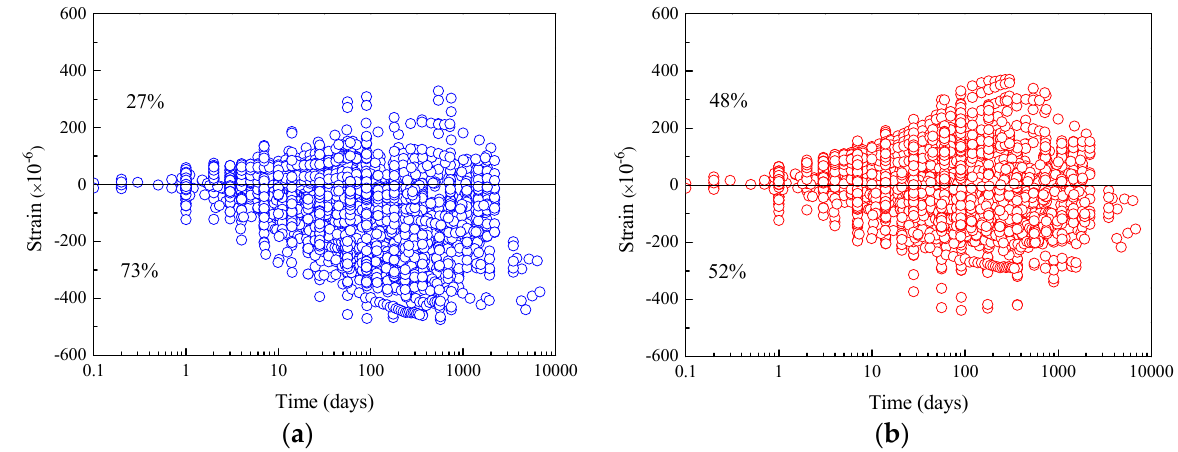
Figure 1. The residuals of shrinkage strain for CEB-FIP models versus time. ( a ) Residuals for CEB-FIP 1990 model. ( b ) Residuals for CEB-FIP 2010 model. Table 3. Distribution of shrinkage strain residuals for CEB-FIP 1990 and 2010 shrinkage